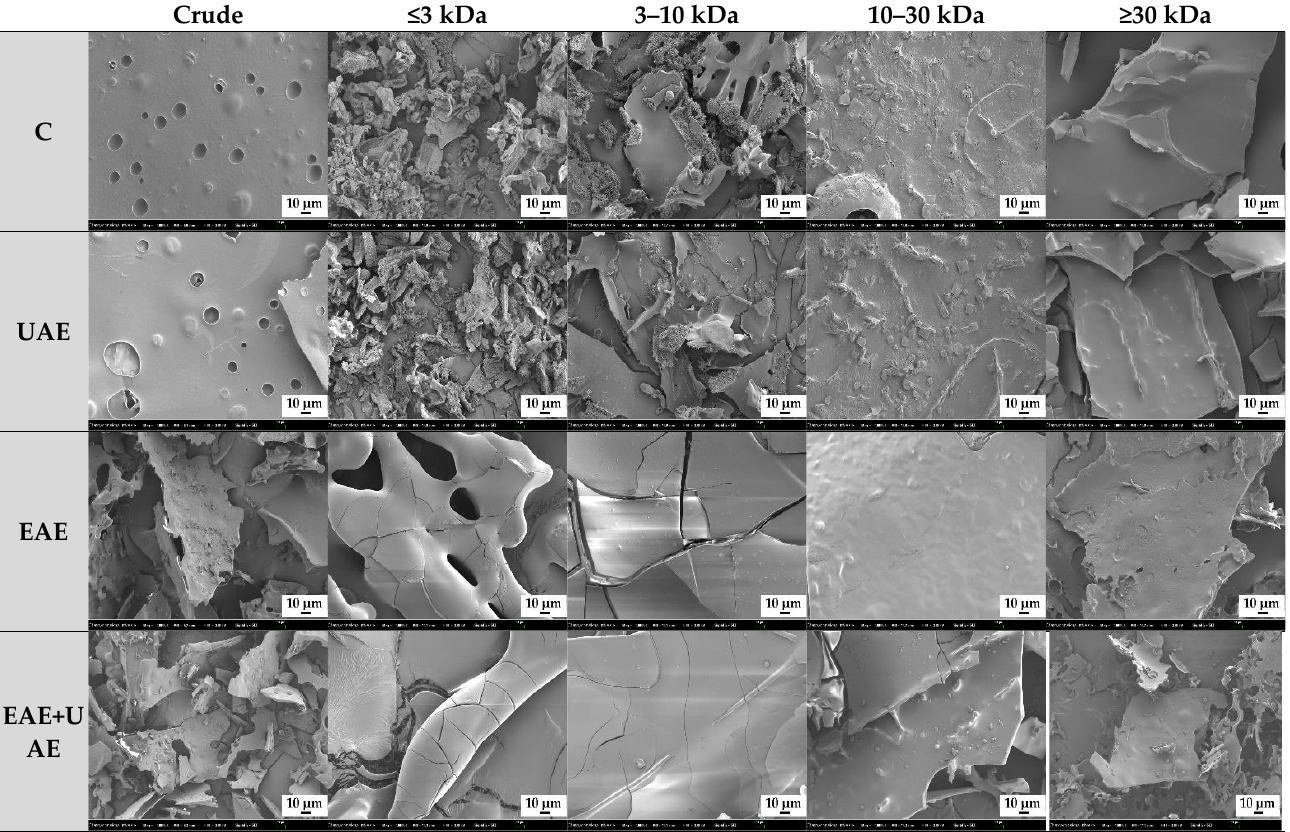
Figure 3. SEM image of collagen hydrolysate fractions extracted from Alaska pollack skin. C, control; UAE, ultrasound assisted extraction method; EAE, enzyme assisted extraction method; EAE+UAE, combination of enzyme and ultrasound assisted extraction methods (1000 ×